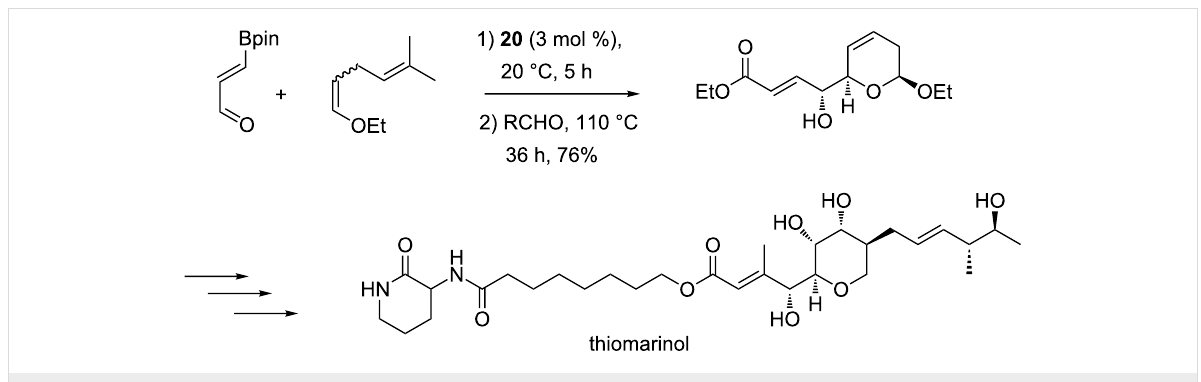
Scheme 19: Total synthesis of a thiomarinol